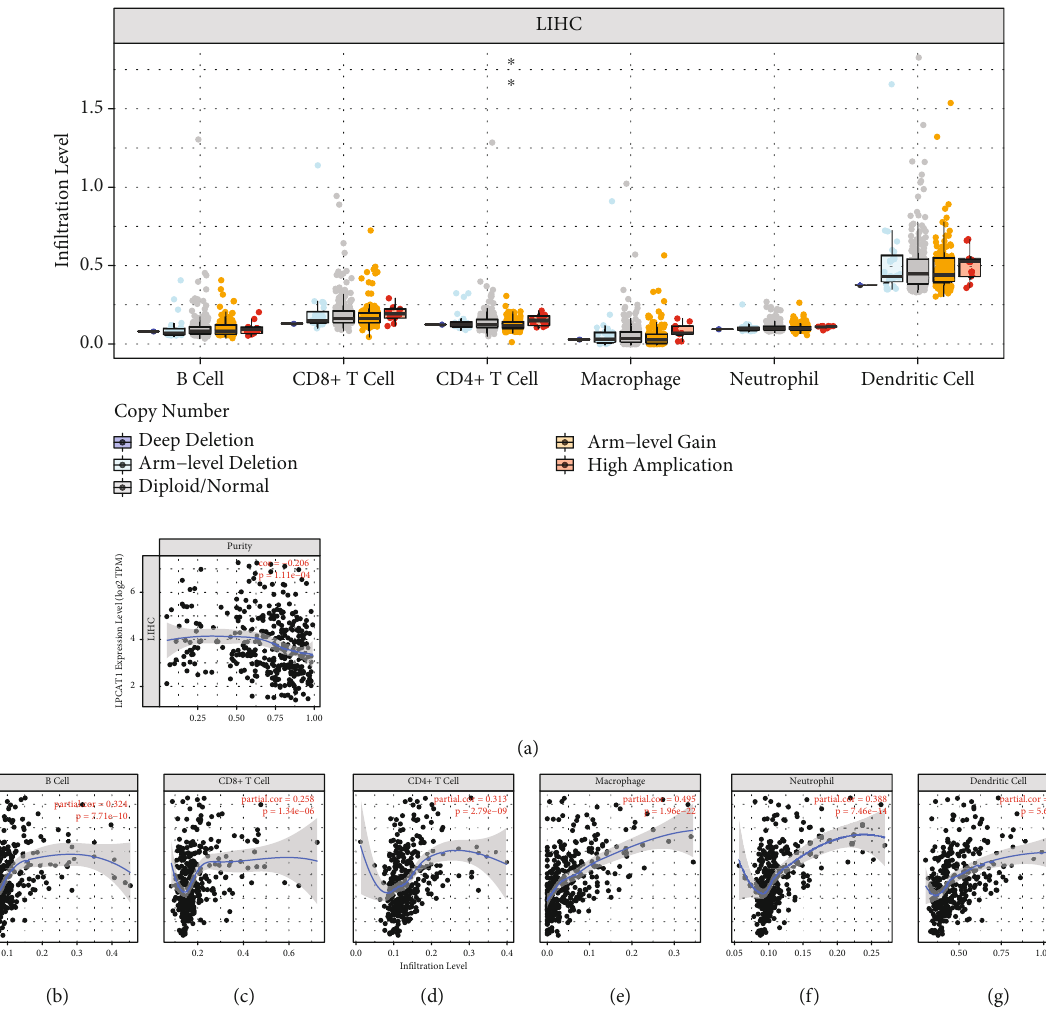
Figure 6: The relationship of immune cell in fi ltration with LPCAT1 level in LIHC. (a) The in fi ltration level of various immune cells under di ff erent copy numbers of LPCAT1 in LIHC. (b) – (g) The correlation of LPCAT1 expression level with B cell (b), CD8+T cell (c), CD4 +T cell (d), macrophage (e), neutrophil (f), or dendritic cell (g) in fi ltration level in